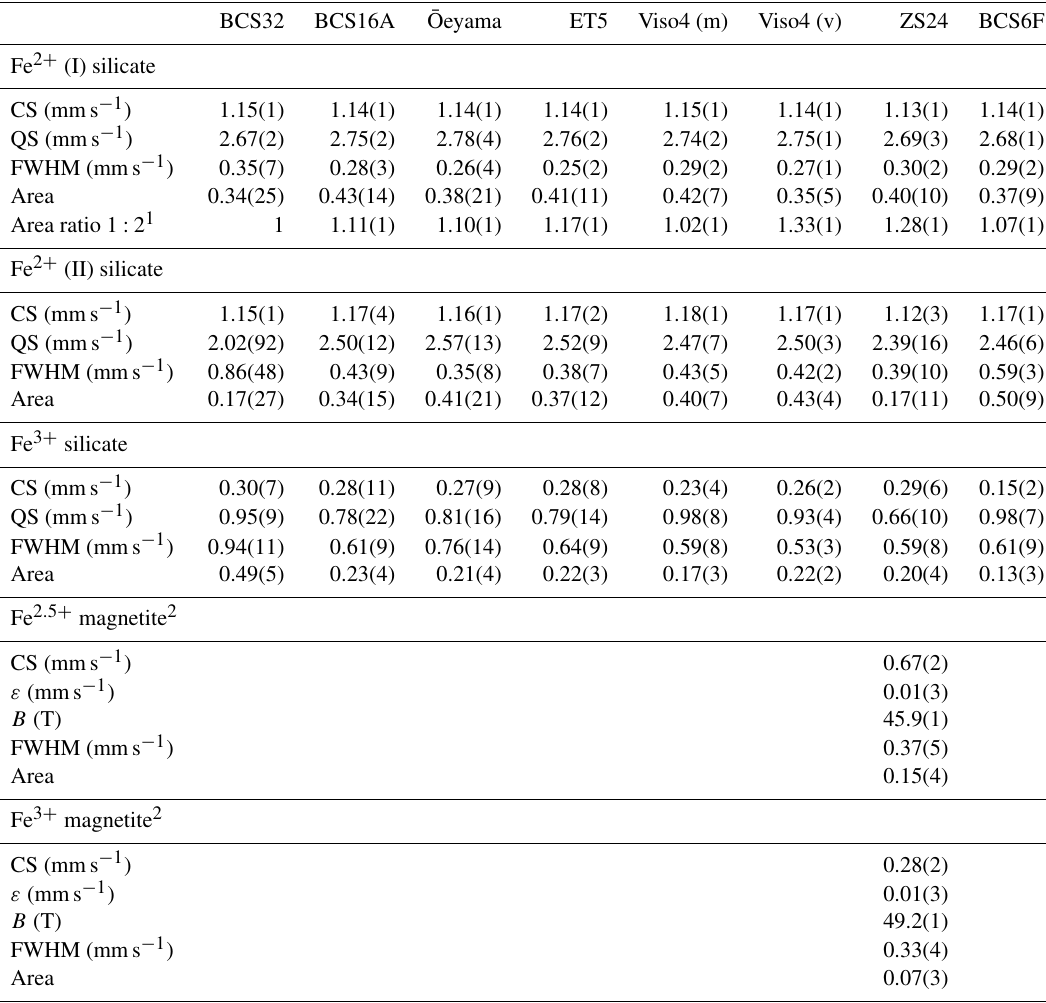
Table 2. Hyperfine parameters derived from room temperature Mössbauer spectra of serpentines and chlorites.